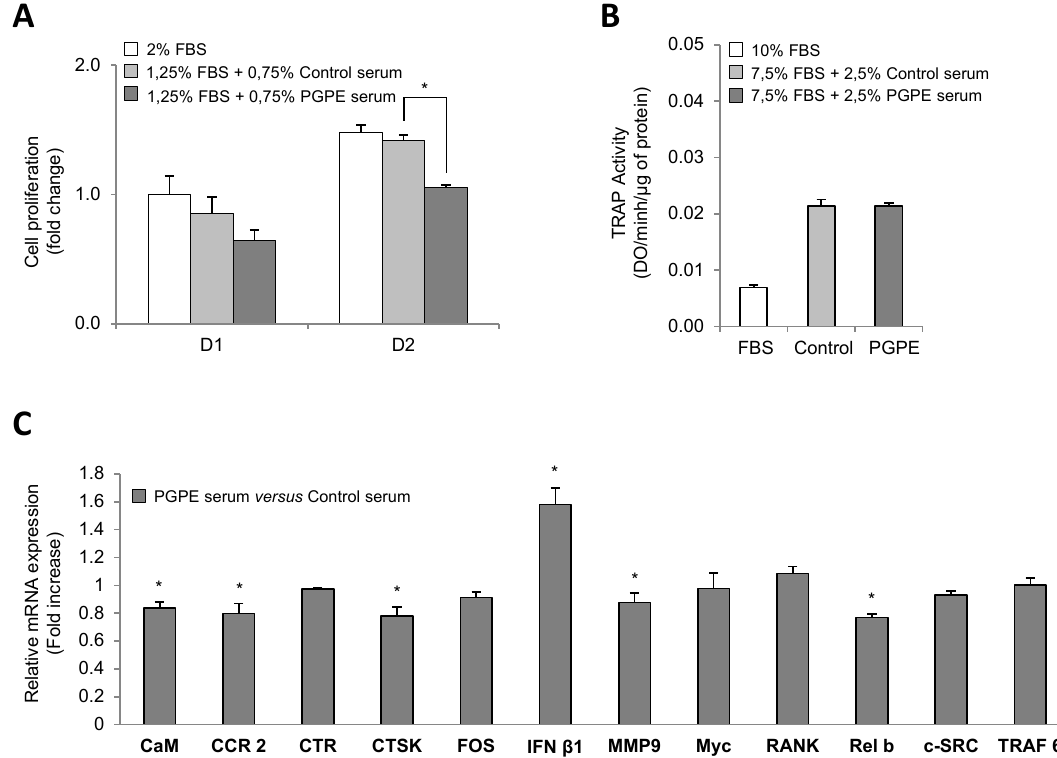
Figure 3. Osteoclast viability, differentiation and transcription in culture after exposure to serum harvested from mice either raised under control conditions or treated with pomegranate peel extract. * p < 0.05 PGPE versus Control condition. ( A ) Cell proliferation test performed on RAW264.7 cell line cultured in minimal medium (2% Fetal Bovine Serum, FBS), supplemented with serum from mice exposed to either physiological serum (1.25% FBS + 0.75% Control mice serum) or pomegranate peel extract, PGPE (1.25% FBS + 0.75 PGPE mice serum) after 1 and 2 days of treatment. Results are expressed as mean ± standard error of the mean (SEM) ( n = 6). ( B ) Tartrate resistant acid phosphatase, TRAP activity of RAW264.7 cells cultured in optimized medium with 10% FBS or with 7.5% FBS + 2.5% mice serum from animals fed either physiological serum (Control) or pomegranate peel extract (PGPE), after 3 days of treatment. Results are expressed as mean ± SEM ( n = 8). ( C ) Transcriptomic analysis of the main osteoclast markers in RAW264.7 cells cultured in optimized medium after 2 days of treatment with serum from mice exposed to either physiological serum (Control) or pomegranate peel extract (PGPE). Transcriptomic analysis of the Raw264.7 mRNA levels determined by Taqman Low density Arrays are presented as fold change compared to Control condition (fold change = 1) as mean ± standard deviation (SD) ( n = 6). Gene: CaM: calmodulin; CCR2: chemokine receptor 2; CTR: calcitonin receptor; CTSK: cathepsin K; FOS; IFN β 1: interferon β 1; MMP9: metalloproteinase 9; Myc, RANK: receptor activator of nuclear factor- κ B; Relb; c-SRC: and TRAF6.